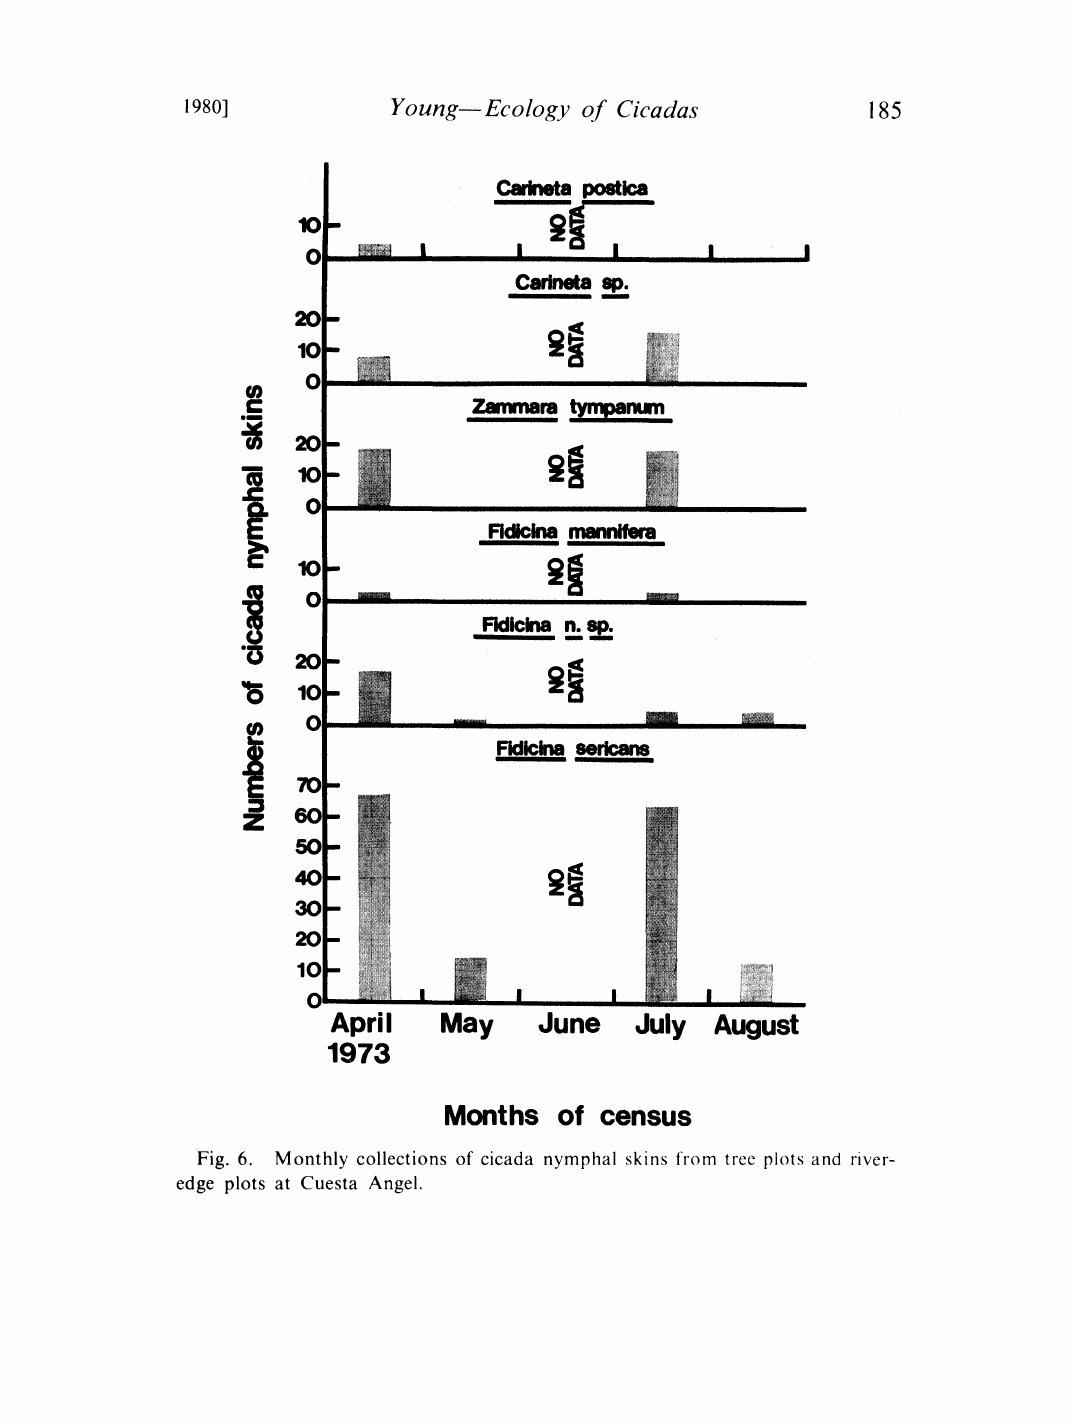
Fig. 6. Monthly collections of cicada nymphal skins from tree plots and river- edge plots at Cuesta